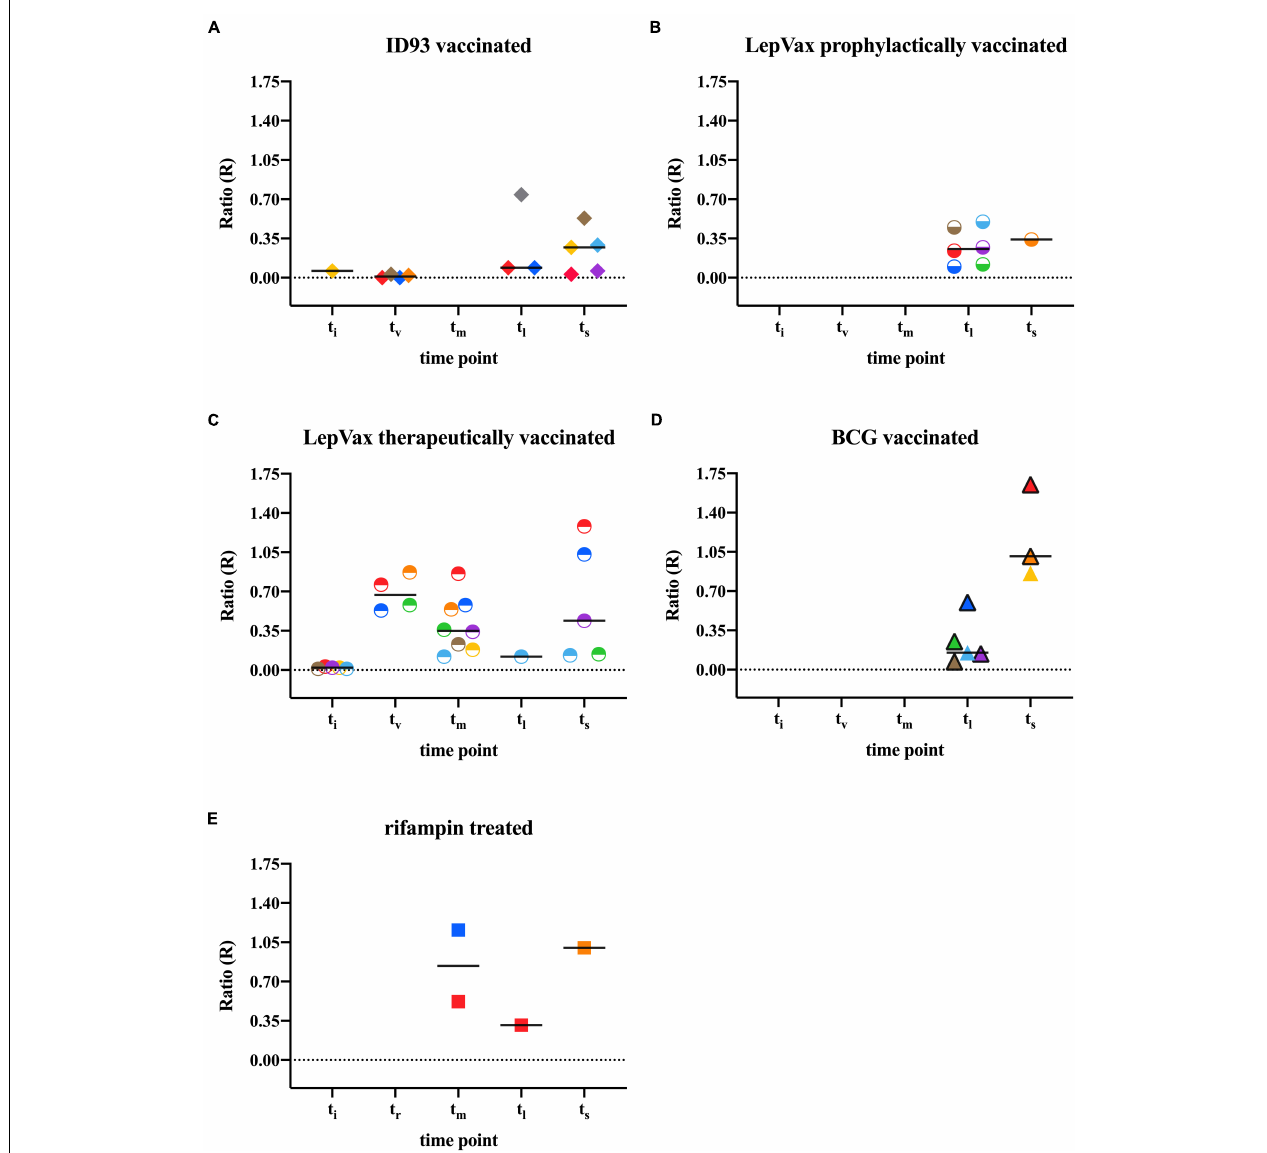
FIGURE 6 | Anti-PGL-I IgM levels by UCP-LFA in M. leprae infected treated/vaccinated armadillos. Anti-PGL-I IgM levels were measured by UCP-LFA in serum from M. leprae [1 × 10 9 bacilli; NHDP 63 ( n = 24), NHDP 98 ( n = 3), or Brazil 4923 ( n = 7)], and one animal was infected in the wild) infected armadillos ( n = 35). 16 armadillos were prophylactically vaccinated with ID93 ( n = 9; A ) or LepVax ( n = 7, B ) 1 month post-infection; eight armadillos were therapeutically vaccinated with LepVax (C) 10–32 months post-infection; Eight armadillos were vaccinated with BCG (D) 1 month pre- ( n = 6, black frame) or post- ( n = 2, colored triangle) infection; Rifampin was provided for 3 months to armadillos ( n = 3) 8 or 10 months post-infection (E) . Sample derived from each animal is represented by the same symbol. UCP-LFA results are displayed as the Ratio value (R; y-axis ) between Test (T) and Flow-Control (FC) signal. The median values of each group are indicated by horizontal lines. Differences in antibody levels between pre-infection (t i ) vs. post-infection (t v /t r /t m /t l /t s ) were determined by Mann-Whitney U -tests. t i , time of inoculation; t v , time of vaccination; t r , time of rifampin treatment; t m , mid-stage disease; t l , late-stage disease; t s , time at